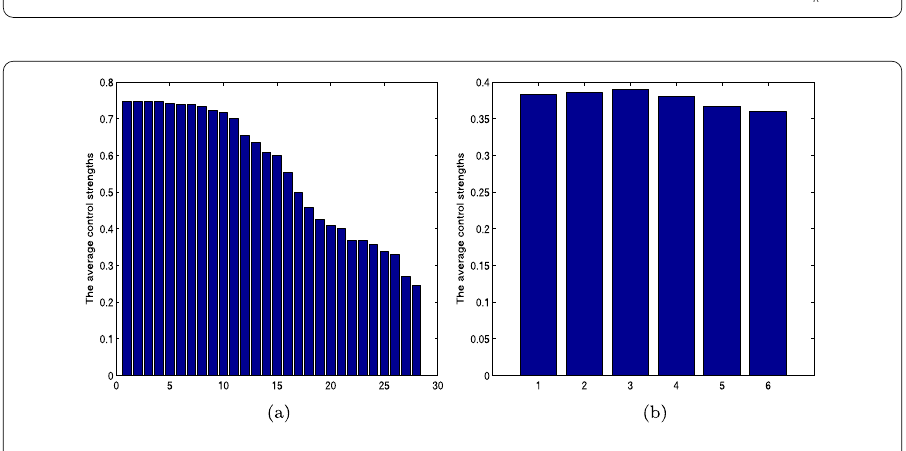
Figure 6 The average control strength ¯ u k , k = 1,2, ... , n